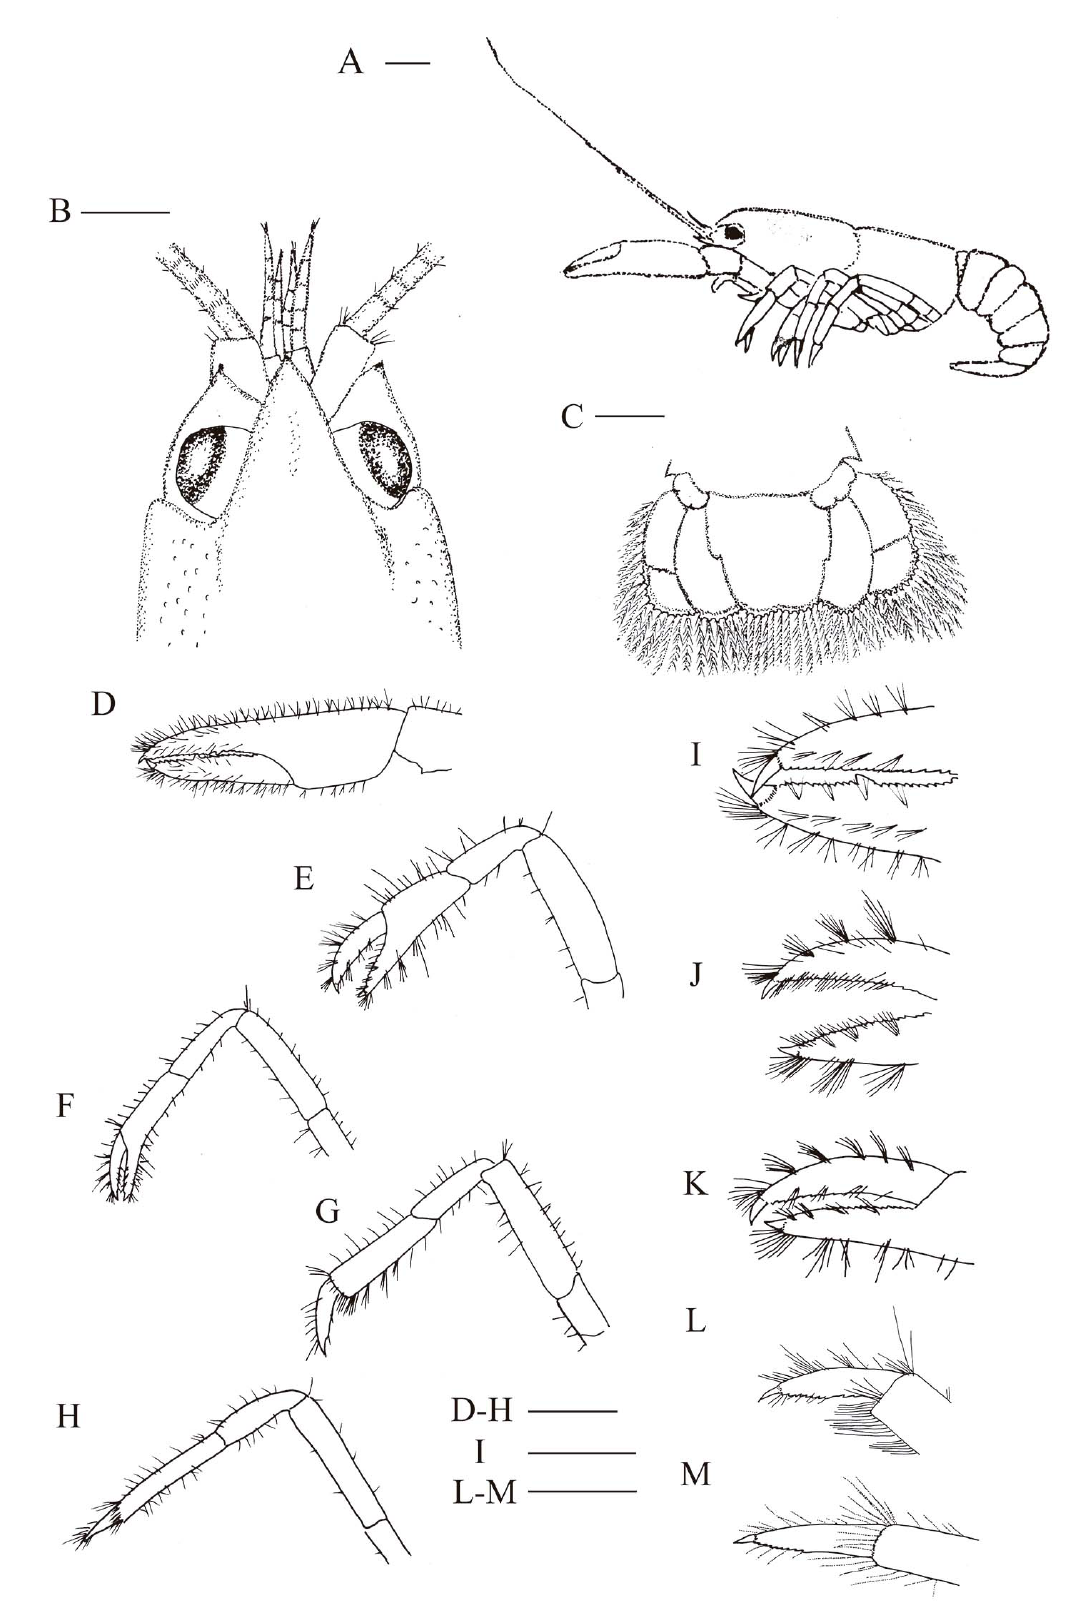
Figure 17. Juvenile Stage III of Cambaroides japonicus. ( A ) Habitus, lateral view; ( B ) eyes and rostrum, dorsal view; ( C ) tail fan, dorsal view; ( D ) posterior edge of tail fan; ( E–I ) pereiopods 1–5, dorsal or lateral view; ( J–N ) distal segments of pereiopods 1–5, dorsal or lateral view. Scale bars: 0.5 mm in A–C, 0.25 mm in